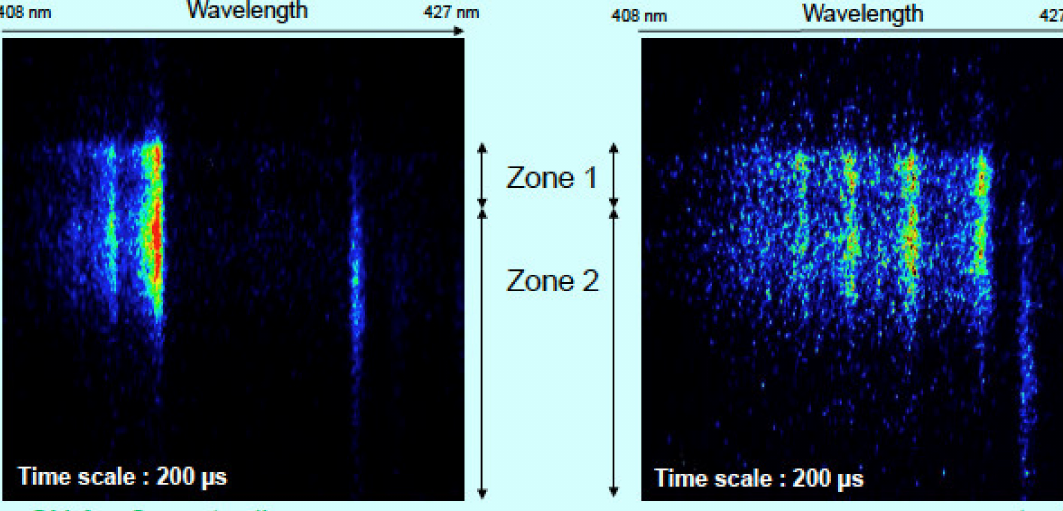
Figure 51. Zones 1 and 2 considered in TCM2 for radiation study (from